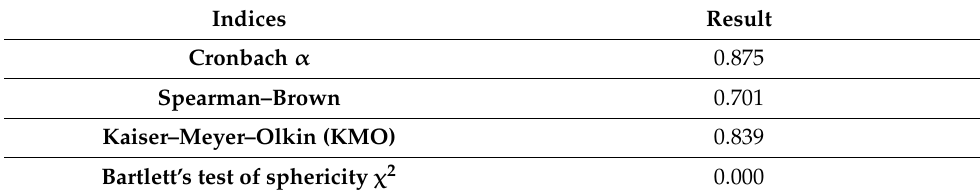
Table 4. Results of indexes in the pre-factor